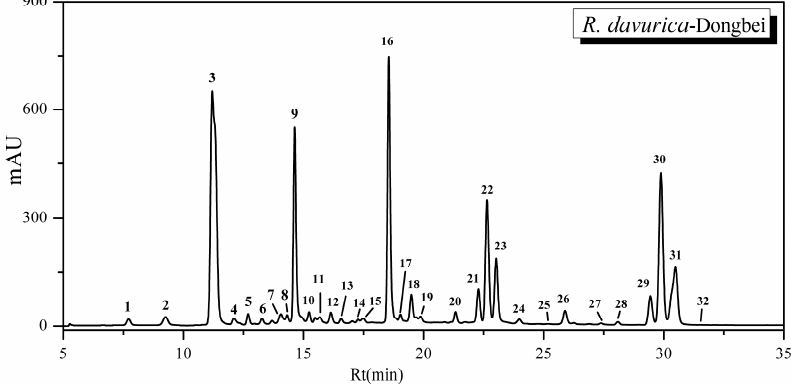
Figure 1. The HPLC-UV chromatogram of R. davurica (Dongbei) at 360 nm using the optimized analytical method. The peak numbers in this figure correspond to those used in Table 1.